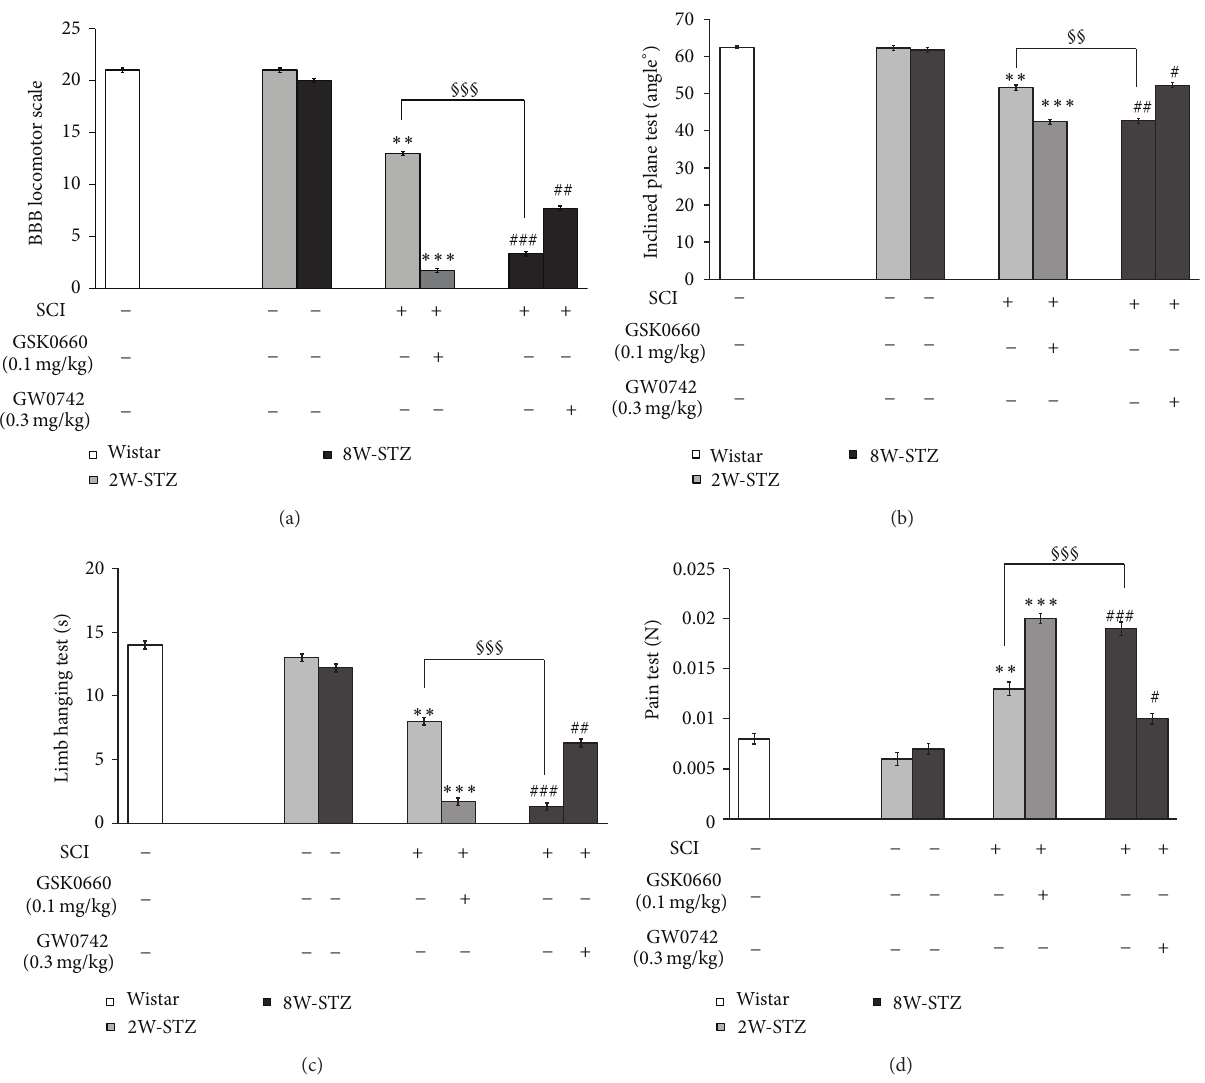
Figure3:ChangesinbehavioralandpaintestsindiabeticratsafterSTZinductionfortwoweeks(2W-STZ)oreightweeks(8W-STZ)receiving SCI surgery or sham operation. The 2W-STZ receiving SCI was further treated with/without GSK0660 (0.1 mg/kg) intravenously once daily for 21 days while the 8W-STZ receiving SCI was further treated with/without GW0742 (0.3 mg/kg) intravenously once daily for 14 days. (a) BBB locomotor scale, (b) inclined plane test, (c) limb hanging test, and (d) pain test. Values (mean ± SE) were obtained from each group of six rats. ∗∗ 𝑃 < 0.01 and ∗∗∗ 𝑃 < 0.001 compared with the 2W-STZ group. # 𝑃 < 0.05 , ## 𝑃 < 0.01 , and ### 𝑃 < 0.001 compared with the 8W-STZ group. §§ 𝑃 < 0.01 and §§§ 𝑃 < 0.001 compared with the 2W-STZ + SCI